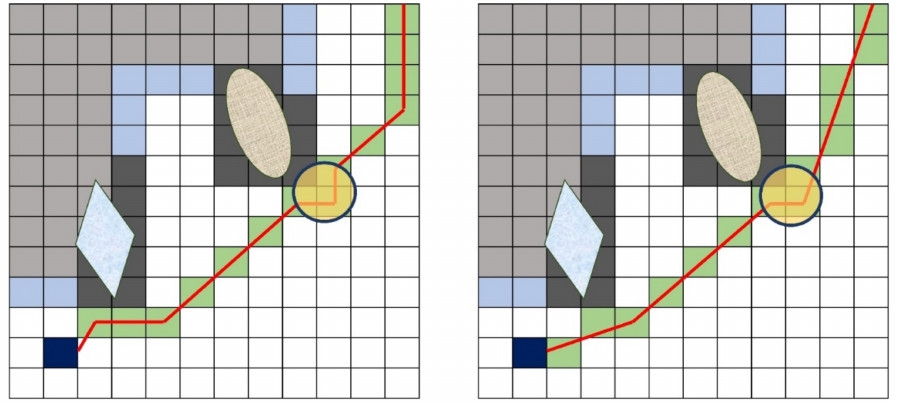
Figure 11. An illustration and comparison of the Hermite interpolation polynomial trajectory optimization (before optimization: left hand side, after optimization: right hand